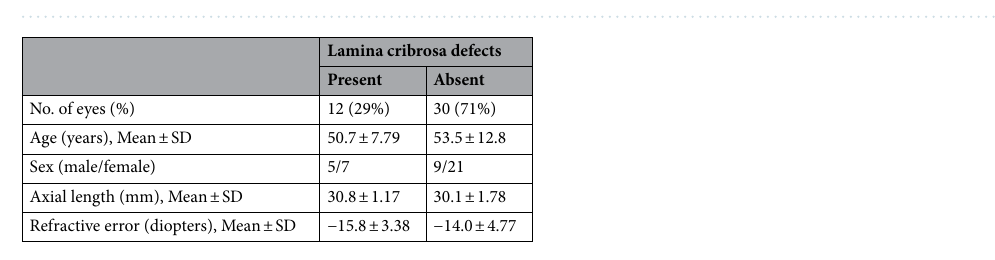
Figure 1. Workflow of deep learning-based 3D OCT imaging of the lamina cribrosa (LC) and LC defects (LCDs). Top row; ( a ) Representative horizontal scan of original 3D SS-OCT image is shown with the area surrounded by a red square where the segmentation was performed. Middle row; Representative images of manual segmentation in the axial ( b ), coronal ( c ), and sagittal ( d ) planes are shown. The lamina cribrosa (LC) is colored red and the peripapillary sclera (PPS) blue. Artificial intelligence (AI) training and segmentation are applied. Bottom row; ( e ) A 3D LC image was generated from the combined AI 3D segmentation results using Fiji 9 (Version 2.1.0/1.53 k).